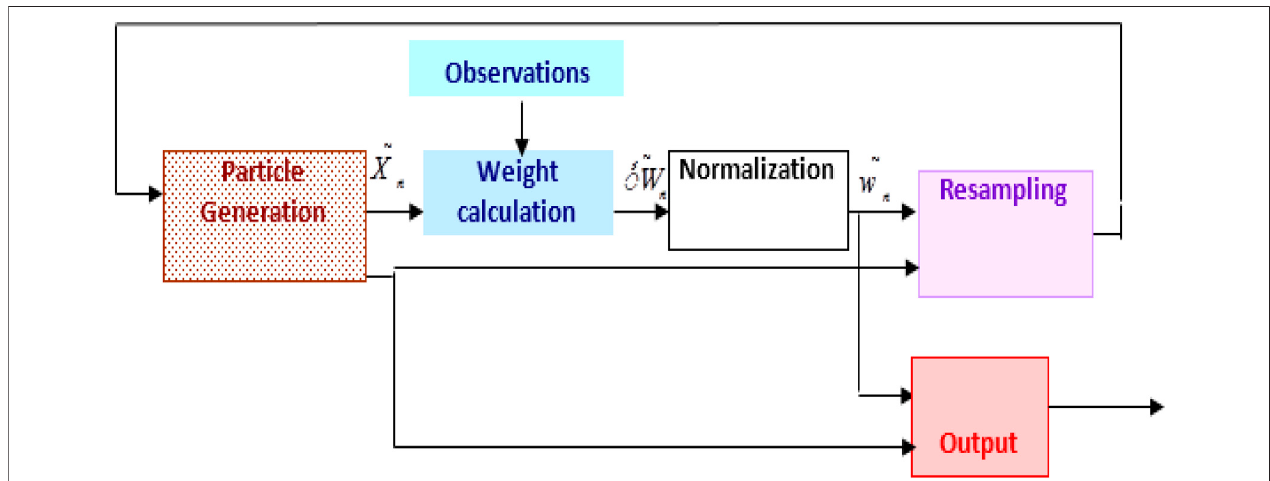
FIGURE 7 | Sampling Importance resampling fi lter